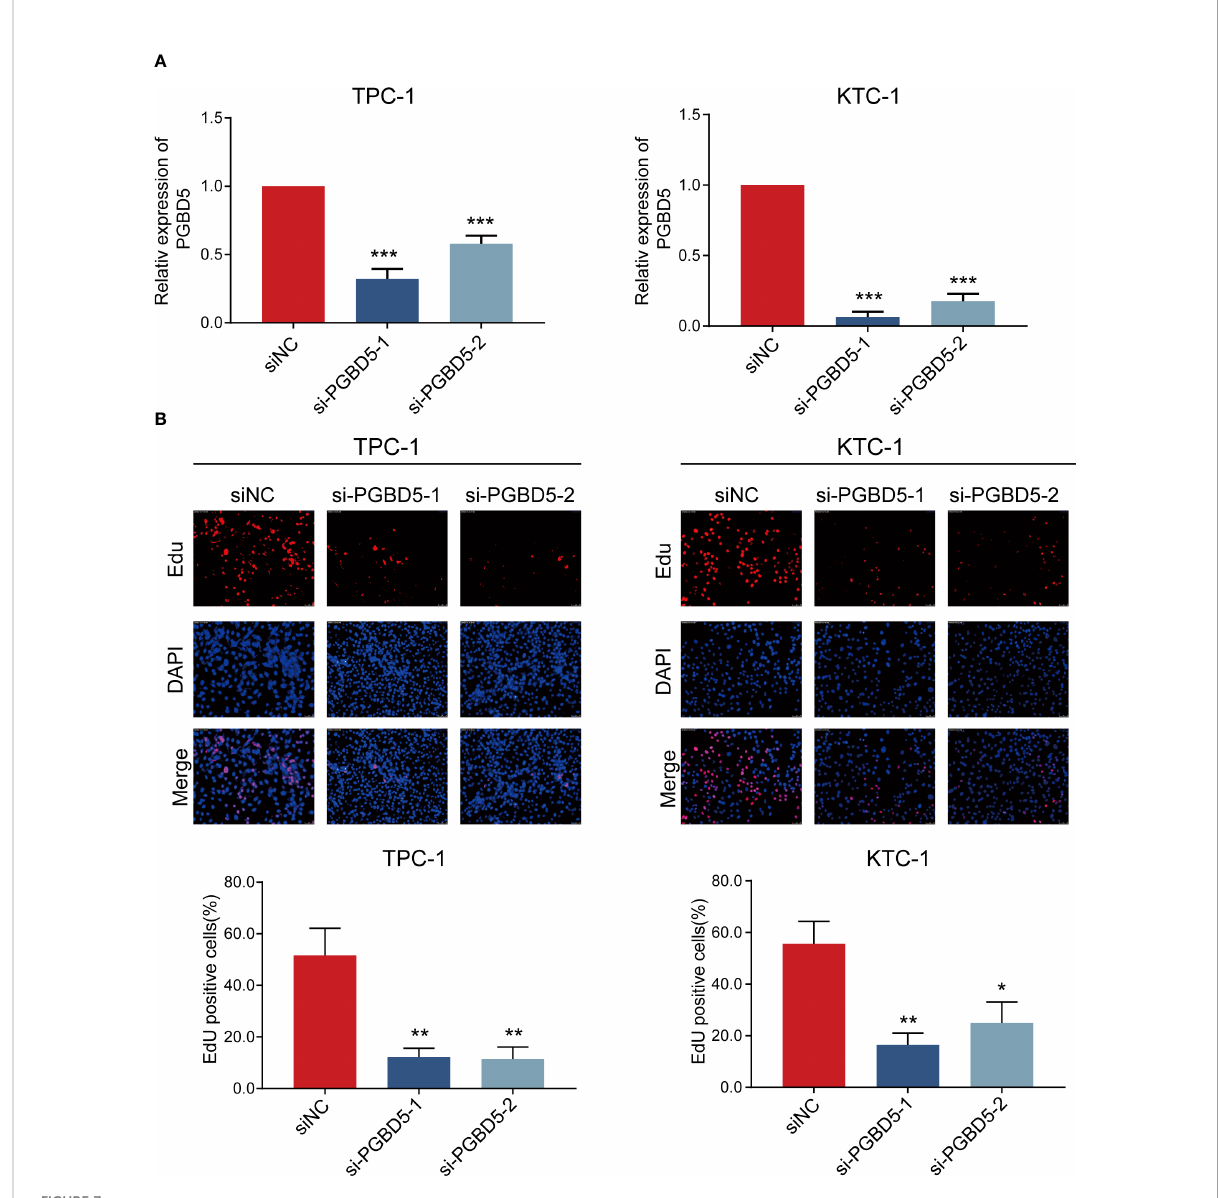
FIGURE 7 PGBD5 promotes PTC cell proliferation. (A) Con fi rmation of PGBD5 knockdown in TPC-1 and KTC-1 cells by RT-qPCR. (B) EdU analysis of TPC- 1 and KTC-1cells after the inhibition of PGBD5. *P < 0.05, **P < 0.01, ***P <